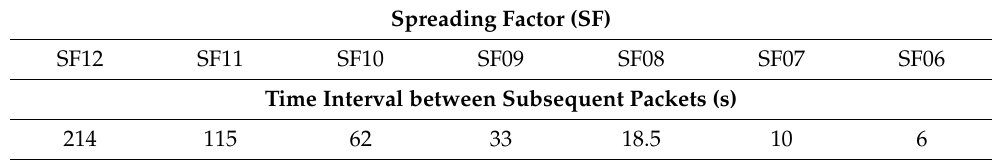
Table 3. Time interval between subsequent packets (1% duty-cycle).